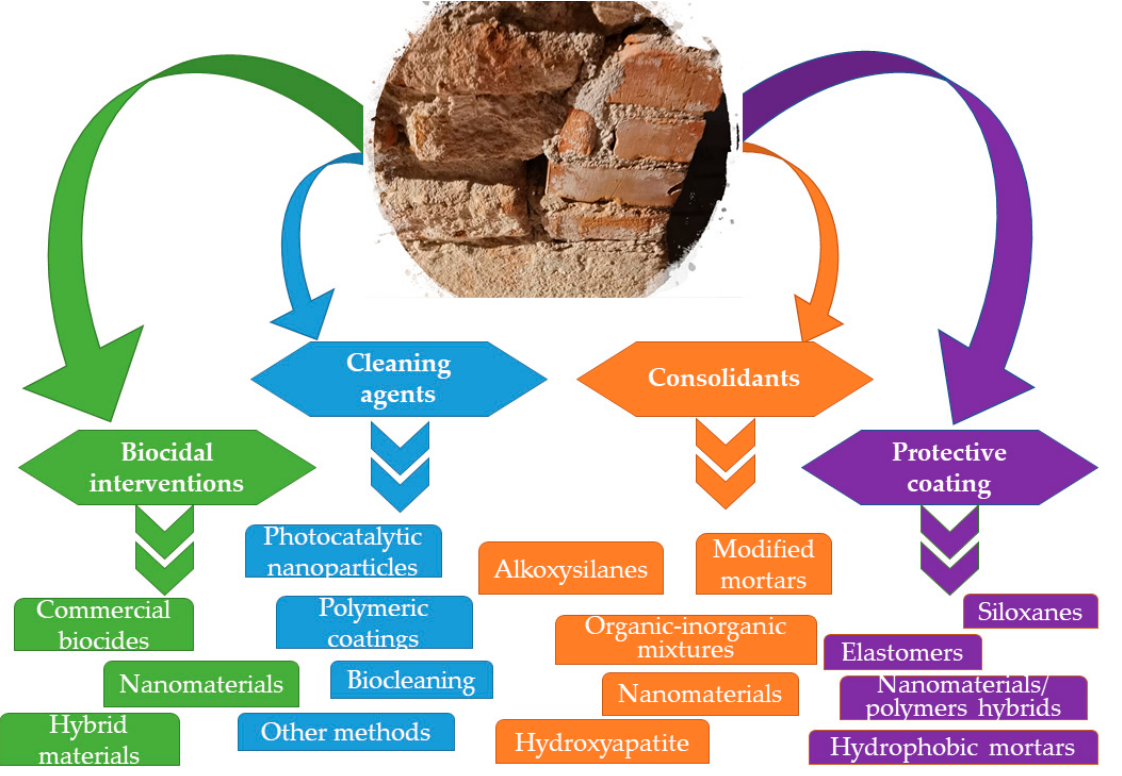
Figure 4. Aspects covered by the present review regarding the conservation and restoration of stone building materials.